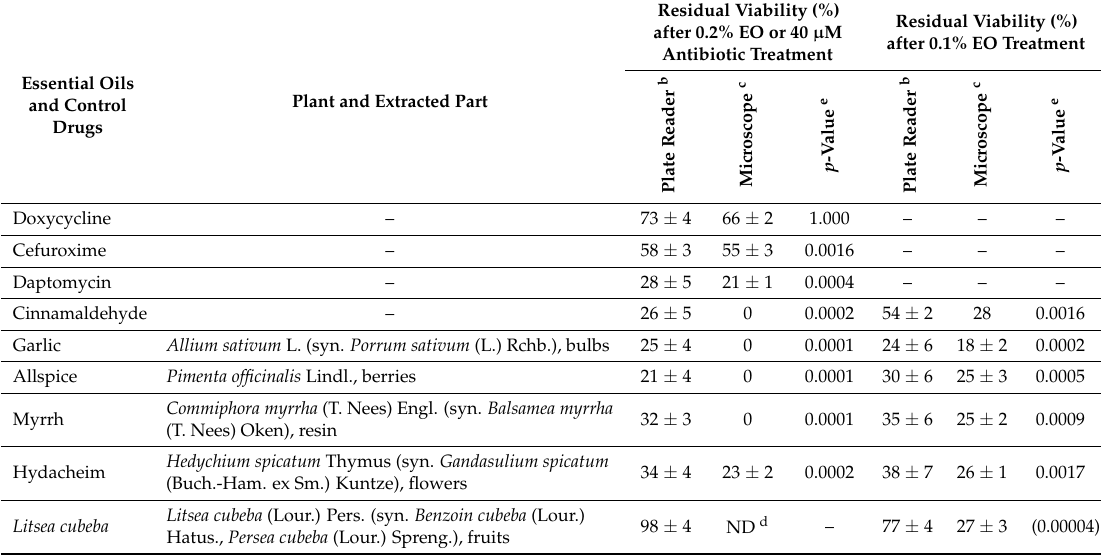
Figure 1. Effect of 0.2% essential oils on the viability of stationary phase B. burgdorferi. A 7-day old B. burgdorferi stationary phase culture was treated with 0.2% ( v/v ) essential oils for seven days followed by staining with SYBR Green I/PI viability assay and fluorescence microscopy. Table 1. Effect of essential oils on a seven-day old stationary phase B. burgdorferi a .